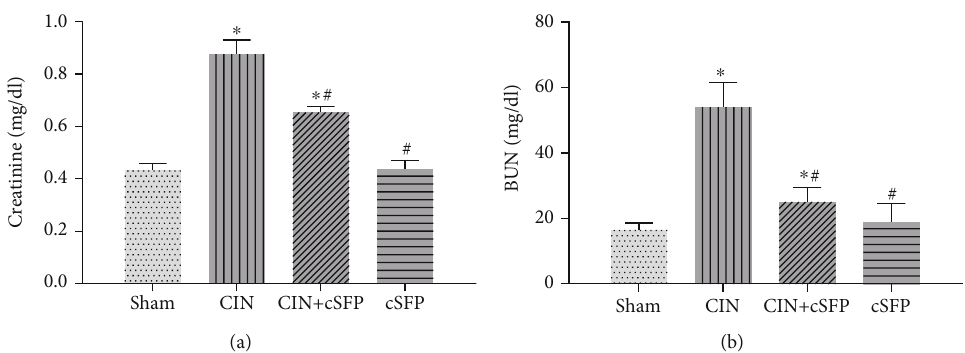
Figure 5: cSFP pretreatment mitigated renal injury against CIN: (a) serum creatinine concentration; (b) serum urea nitrogen concentration. ∗ P < 0 : 05 versus sham rats; # P < 0 : 05 versus CIN rats.